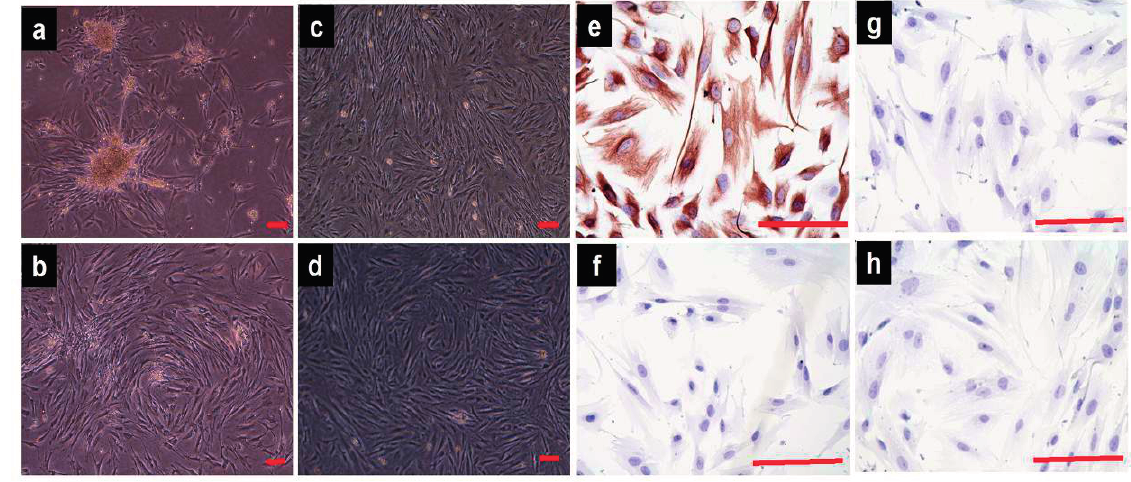
Figure 1. Morphological characteristics and immunocytochemical identification of vaginal fibroblasts (images acquired with an inverted microscope). Primary cultured pelvic organ prolapse (POP) fibroblasts (passage 0) after 72 h ( a ) and 7 days ( b ); POP fibroblasts at passages 4 ( c ) and 5 ( d ). Streptavidin-peroxidase (SP) immunohistochemical staining of POP fibroblasts (passage 4): The characteristic staining of vimentin ( e ), cytokeratin ( f ), α -smooth muscle actin ( g ), and negative control ( h ). Bar = 100 μ